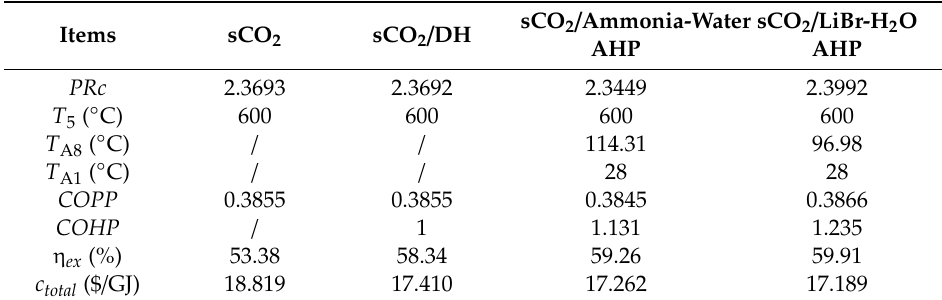
Table 15. Optimized results for the cost optimal design